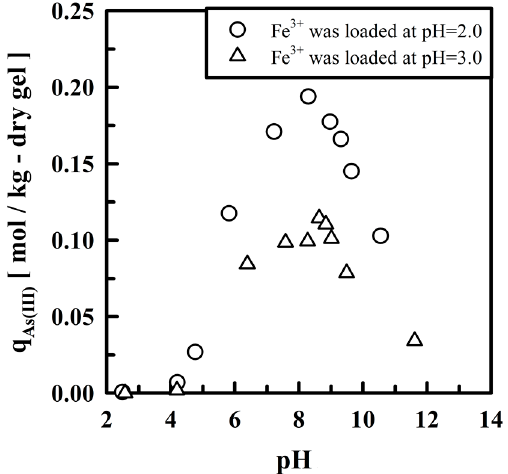
Figure 12. Amount of As(III) adsorbed (q As(III) ) by crosslinked pectic acid gel loaded with Fe(III) plotted against the equilibrium pH [12]. (With permission for reuse from The Society of Chemical Engineers, Japan).